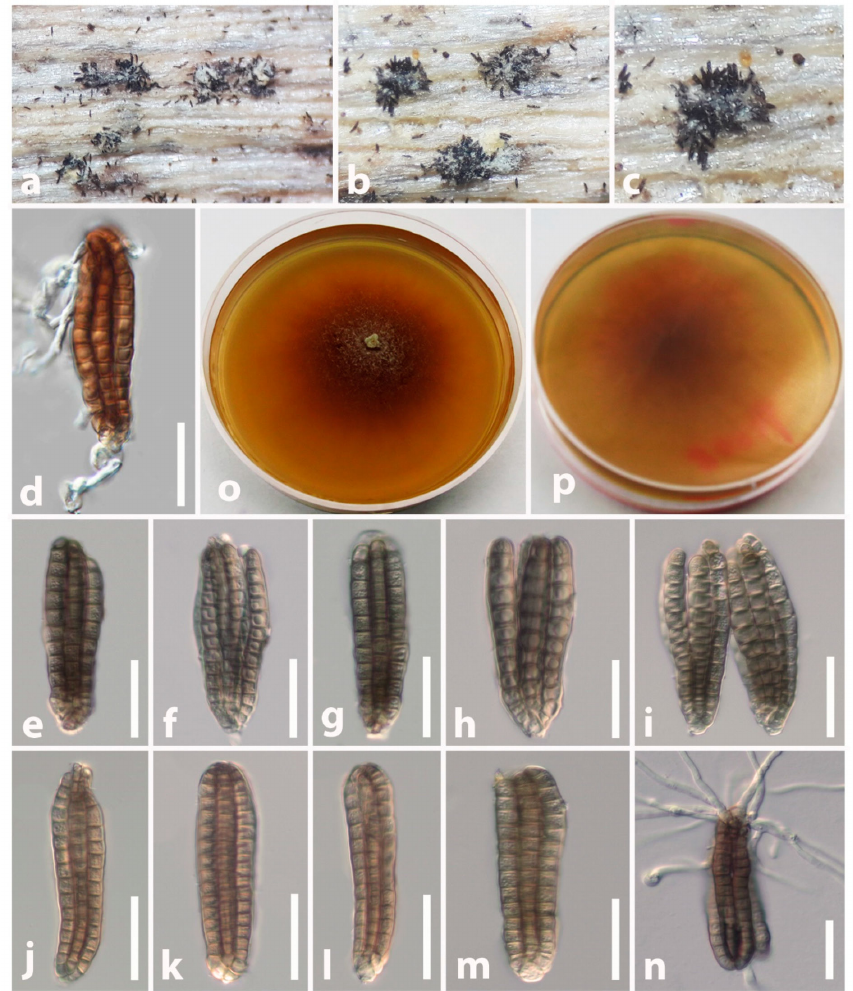
Figure 4. Dictyocheirospora taiwanense (CMUB 39981, new host record ). ( a , b ) Sporodochia on dead stem of Ficus benjamina . ( c ) Close-up of Sporodochium. ( d ) Conidiogenous cell with a conidium. ( e – m ) Conidia. ( n ) A germinating conidium. ( o ) Colonies from above (on PDA/4 weeks). ( p ) Colonies from below (on PDA/4 weeks). Scale bars: ( d – n ) = 30 µ m. 3.2.2. Dictyosporium Corda, Weitenwe’er’s Beitr. Nat. 1: 87